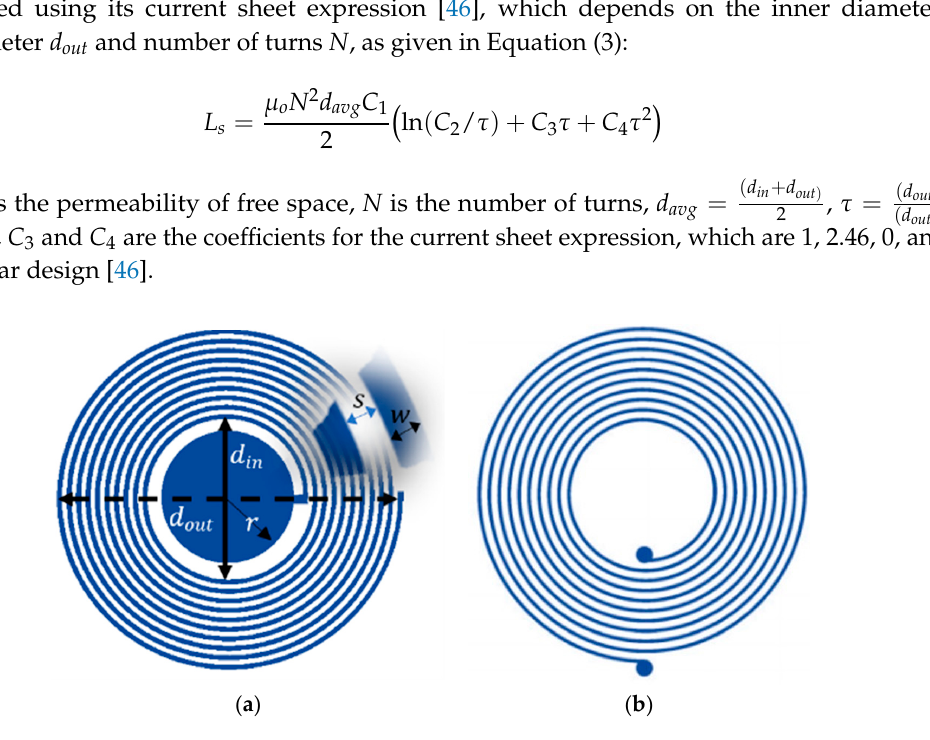
Figure 2. Geometrical representation of the proposed LC system: ( a ) LC sensor with a capacitor of the radius ( r ) and planar inductor with an inner diameter ( d in ) shown with a solid line, outer diameter ( d out ) shown with a dotted line, trace separation ( s ) and trace width ( w ); ( b ) Reader antenna with the same design parameters ( d in , d out , s , w ).